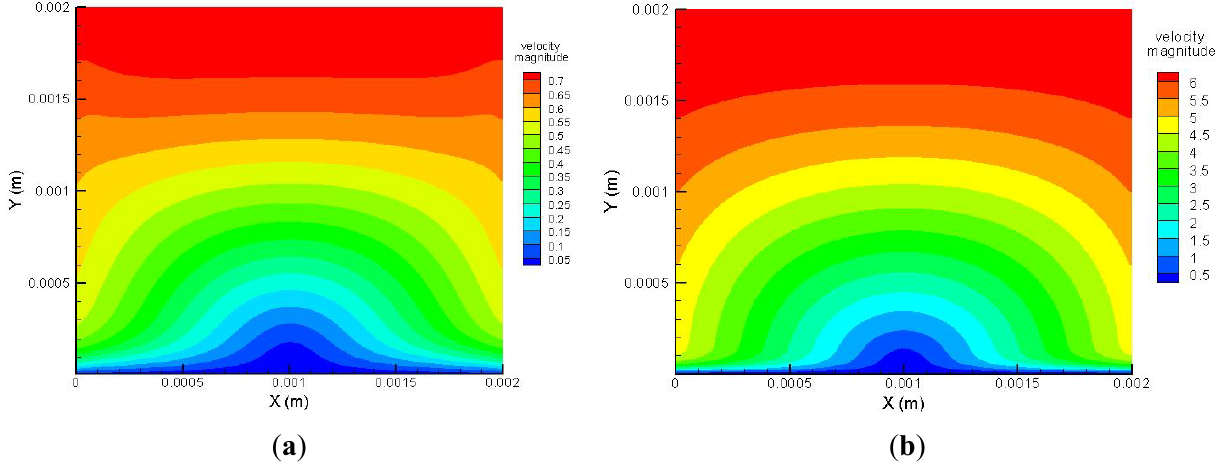
Table 1. Effect of fluid drag force on particles ( d